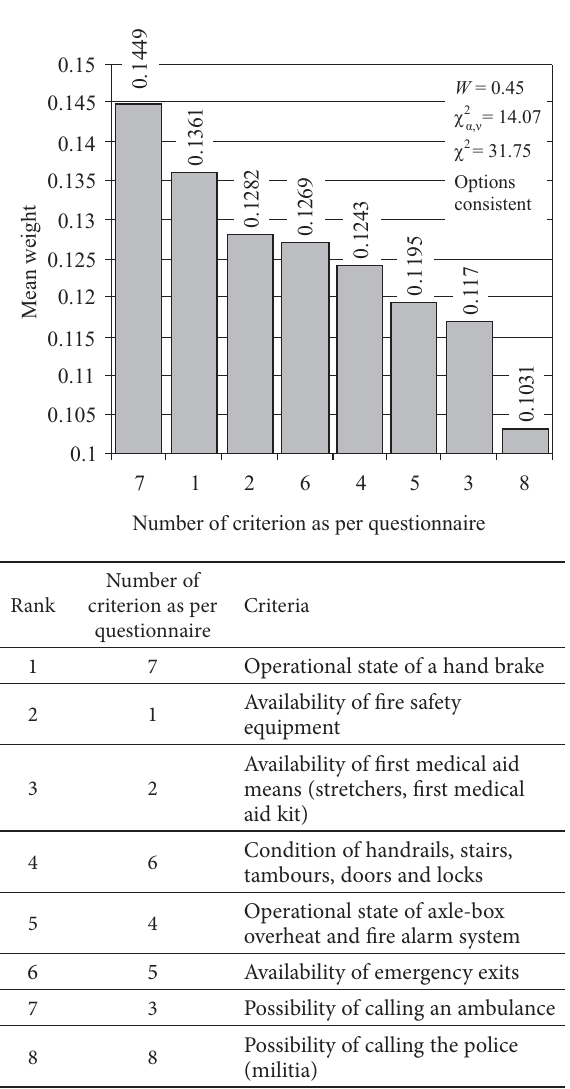
Fig. 6. Th e bar diagram showing the importance of criteria related to the safety of the railway trip determined based